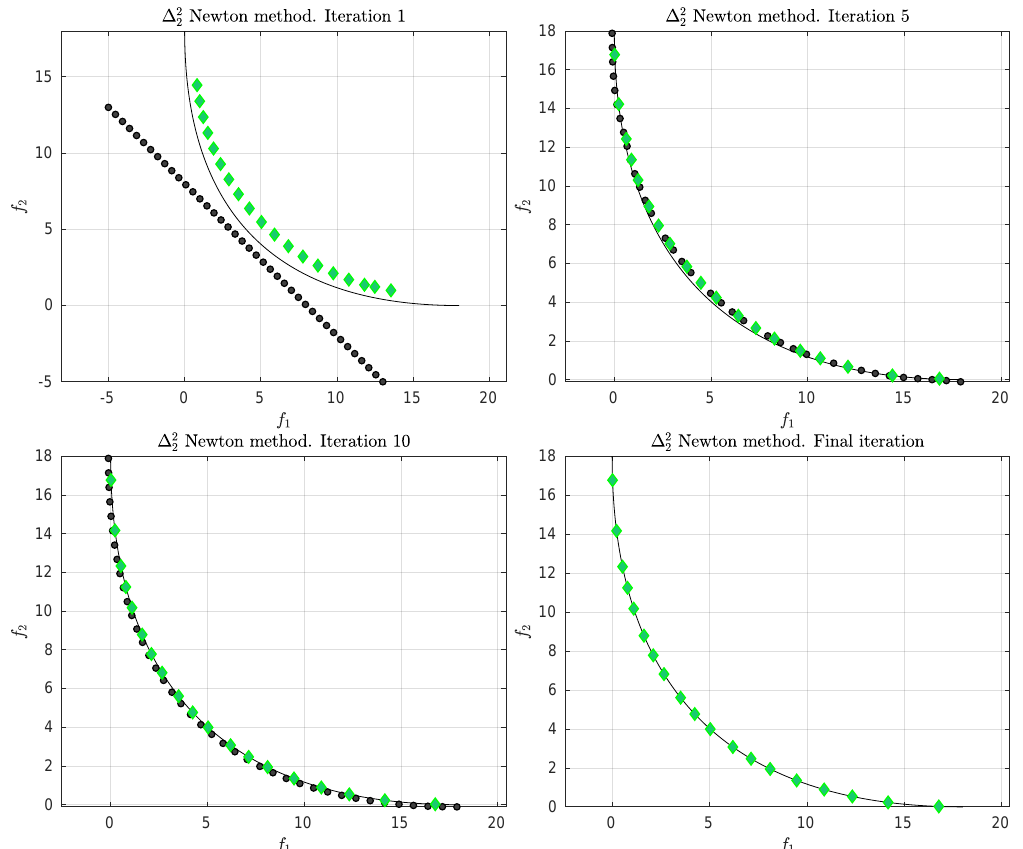
-Newton method to obtain the Pareto front of MOP (27) via the 2